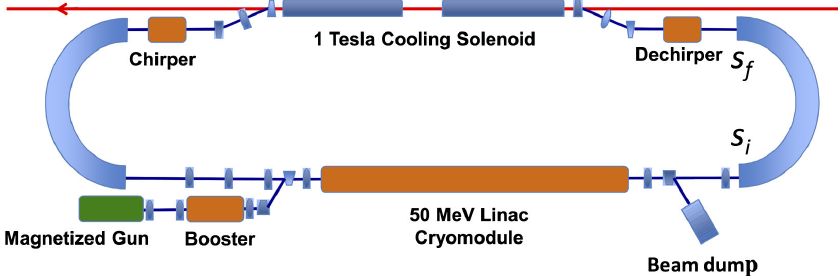
FIG. 5. Schematic layout of the JLEIC ERL cooler design